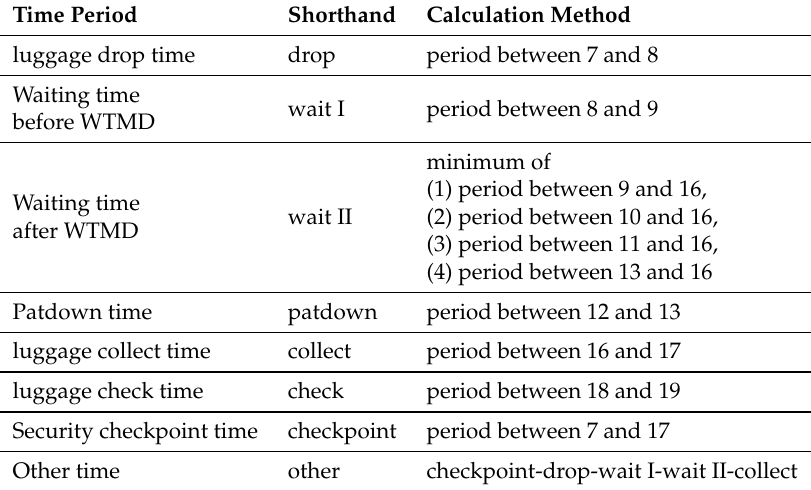
Table 4. The extracted process duration from the gathered data, based on the entries as specified in Table